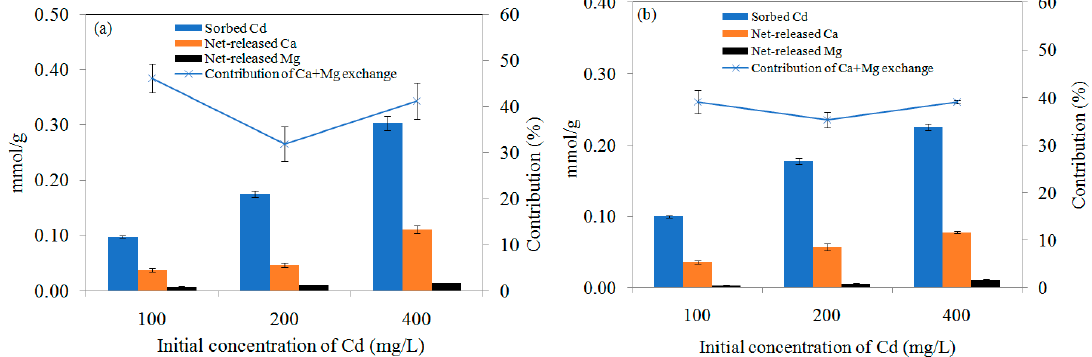
Figure 10. Net-released Ca 2+ and Mg 2+ for ( a ) MSB500 and ( b ) PLB500 during Cd adsorption with the initial concentration increasing from 100 to 400 mg/L at pH 6.0.